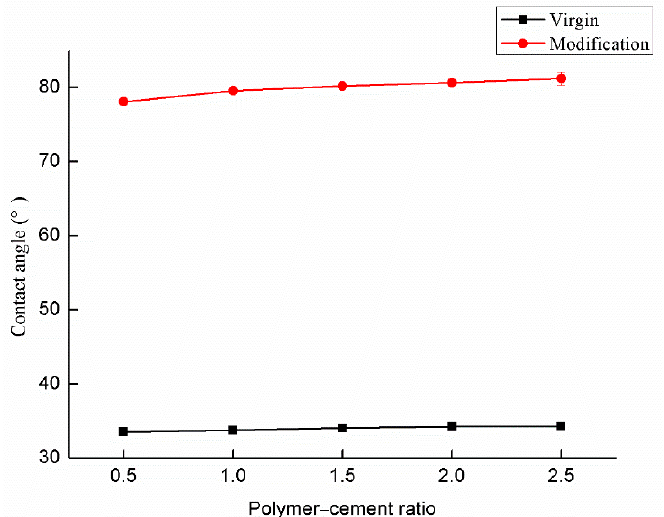
Figure 10. Comparison of contact angle before and after modification.